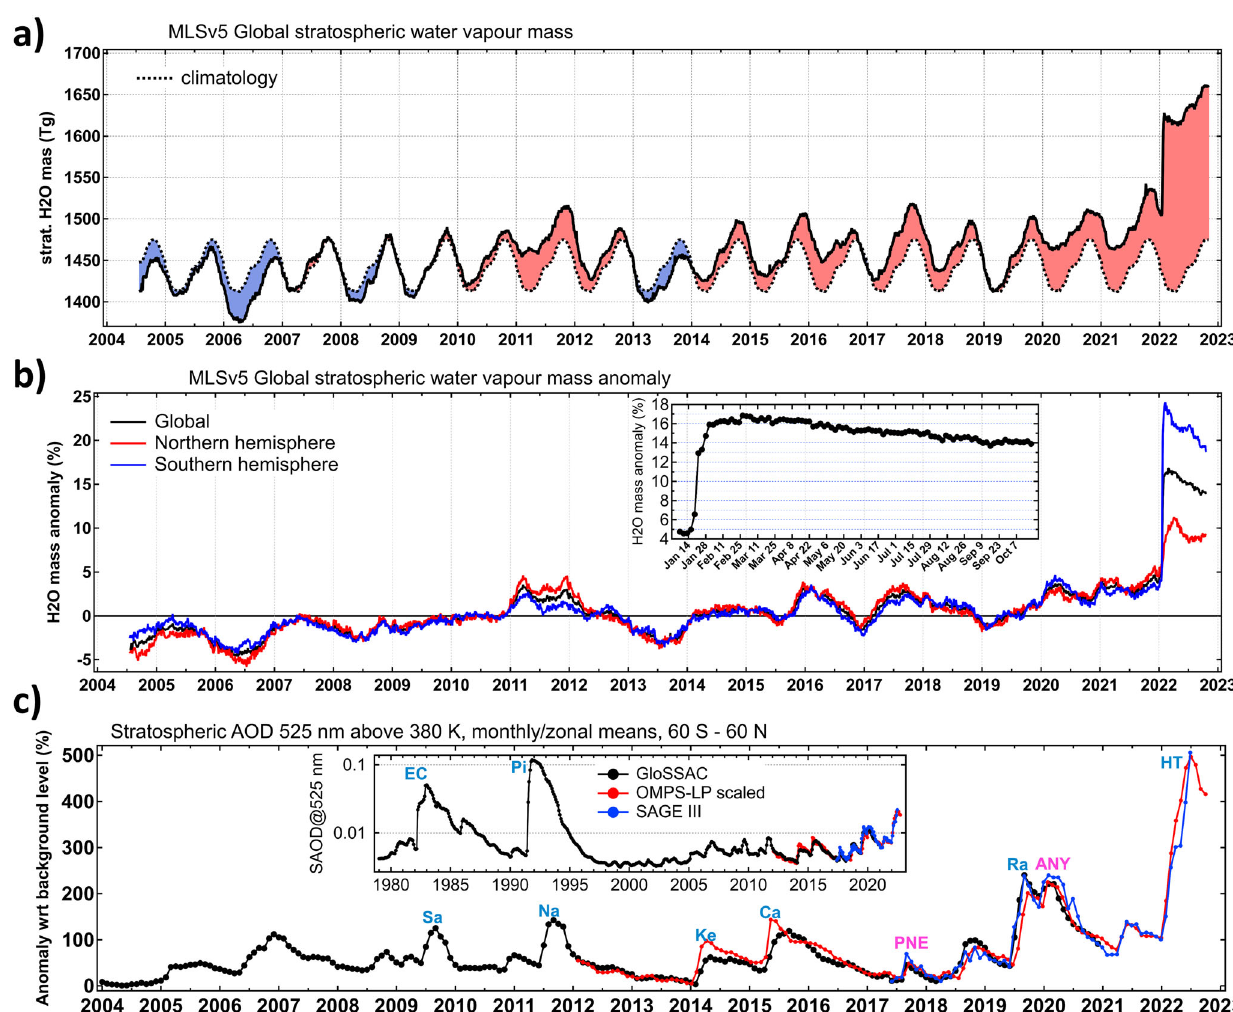
Fig. 10 Global perturbation of stratospheric water vapour and aerosol burden. a Evolution of the global MLS V5 stratospheric water vapour mass (3-day averages) between 100 hPa – 1 hPa pressure levels (solid black curve) and climatological (2004-2021 period) annual cycle (dashed curve), the positive and negative anomalies are shown respectively as red and blue shading. b Deseasonalized stratospheric water vapour mass anomaly (per cent 3-day averages) for both hemispheres and the whole globe from MLS. The embedded panel shows the evolution of global anomaly in 2022. c Stratospheric aerosol optical depth (SAOD) anomalies for the 60° S – 60° N latitude band (monthly averages) from GloSSAC merged satellite record extended using OMPS-LP measurements at 675 nm scaled to 525 nm wavelength using GloSSAC data and SAGE III/ISS measurements at 521 nm converted to 525 nm using SAGEIII-derived Angstrom exponent. The SAOD anomalies are computed with respect to the background level estimated as GloSSAC SAOD average over volcanically-quiescent 1995 – 2003 period. The embedded panel shows the full time span of SAOD series. The cyan and pink letters indicate the most signi fi cant volcanic eruptions and wild fi re events respectively (EC El Chichon, Pi Pinatubo, Sa Sarychev, Na Nabro, Ke Kelud, Ca Calbuco, PNE Paci fi c Northwest wild fi re event, Ra Raikoke, ANY Australian New Year wild fi re event, HT Hunga